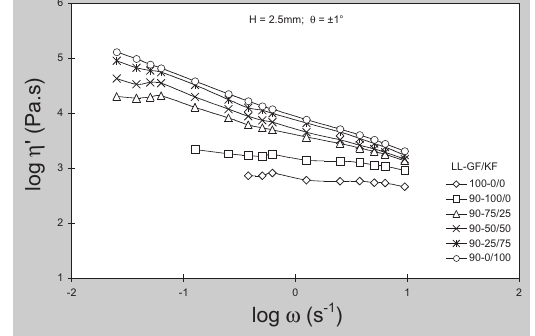
Figure 5 (left): Dynamic viscosity, h ’, as a function of angular frequency, w , for LLDPE and 10 vol% fibre reinforced LLDPE. Figure 6 (right): Dynamic viscosity, h ’, as a function of angular frequency, w , for 20 vol% fibre reinforced LLDPE.